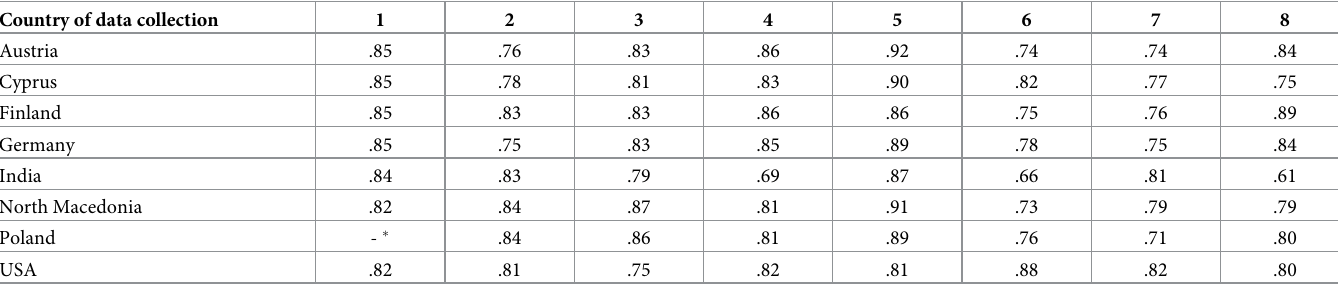
Table 2. Composite reliabilities of the scales per country. Country of data collection